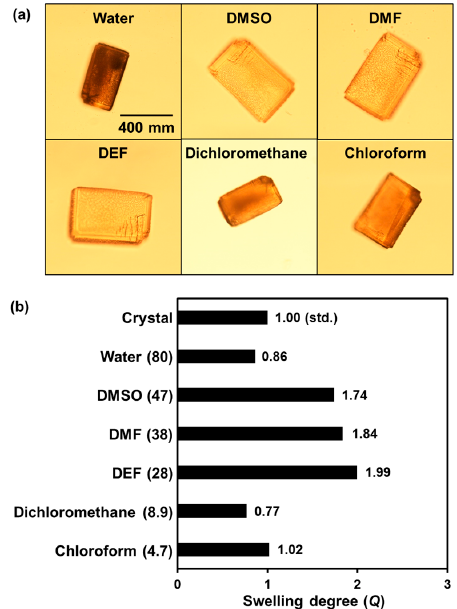
Figure 3. ( a ) Photographs of KUCCG(TPE) in various solvents; ( b ) Swelling degree ( Q ) of KUCCG(TPE) in various solvents. The value in parenthesis indicates the permittivity ( ε ) of each solvents. DEF: N , N -diethylformamide.